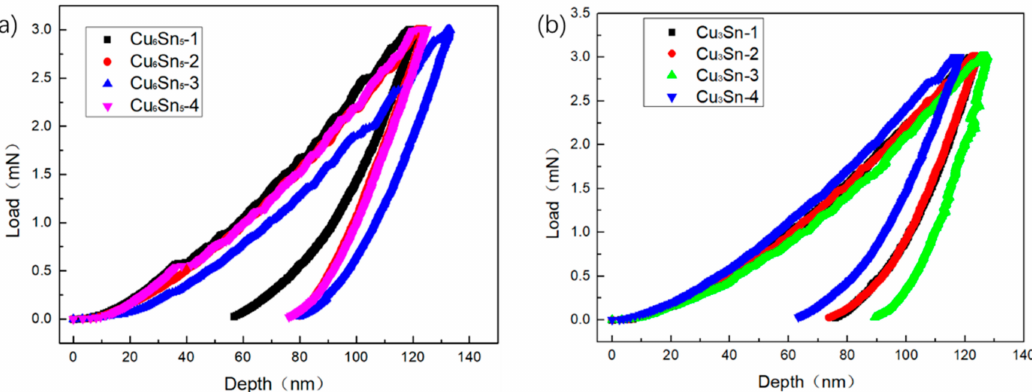
Figure 9. Curves of load vs indentation depth in nanoindentation experiment:( a ) Cu 6 Sn 5 ; ( b ) Cu 3